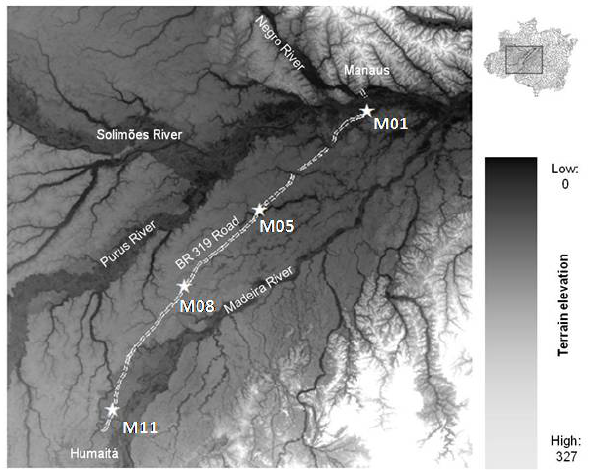
Fig. 1. Map of the Purus–Madeira interfluvial area that is crossed by the BR-319 Highway. The study sites are indicated by white as- teriks. All study sites are sampling modules (M) of the PRONEX- Project “Rapid Assessment for Long Duration Ecological Projects”